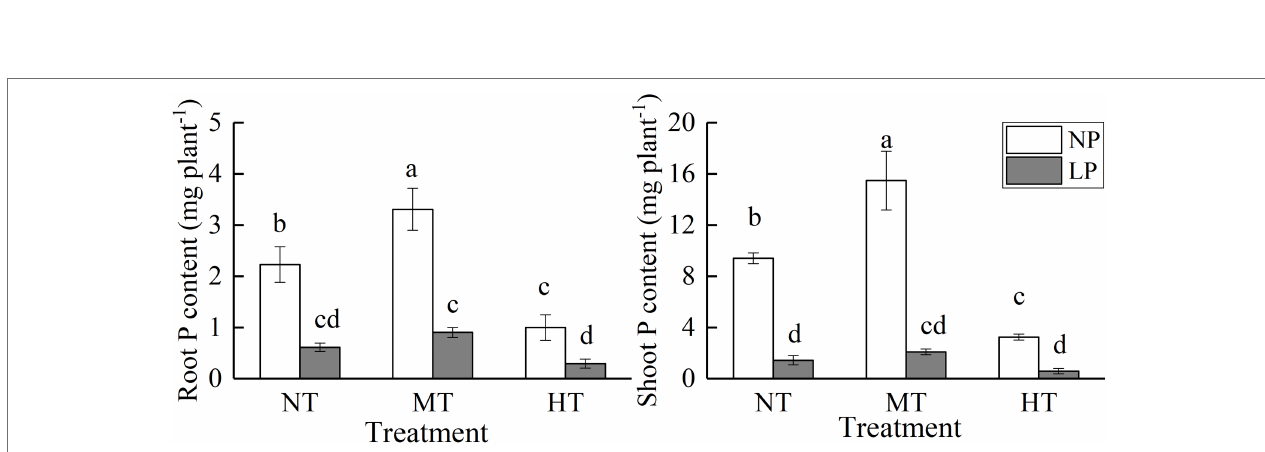
FIGURE 3 | Effect of root zone temperature and phosphorus content on root and shoot phosphorus content. NT: 24 ° C, MT: 30 ° C, and HT: 36 ° C (root zone temperature); LP: 1.25 μ m and NP: 250 μ m (phosphorus content). Notations above bars of a, b, c, and d indicate homogeneous groups ( α =